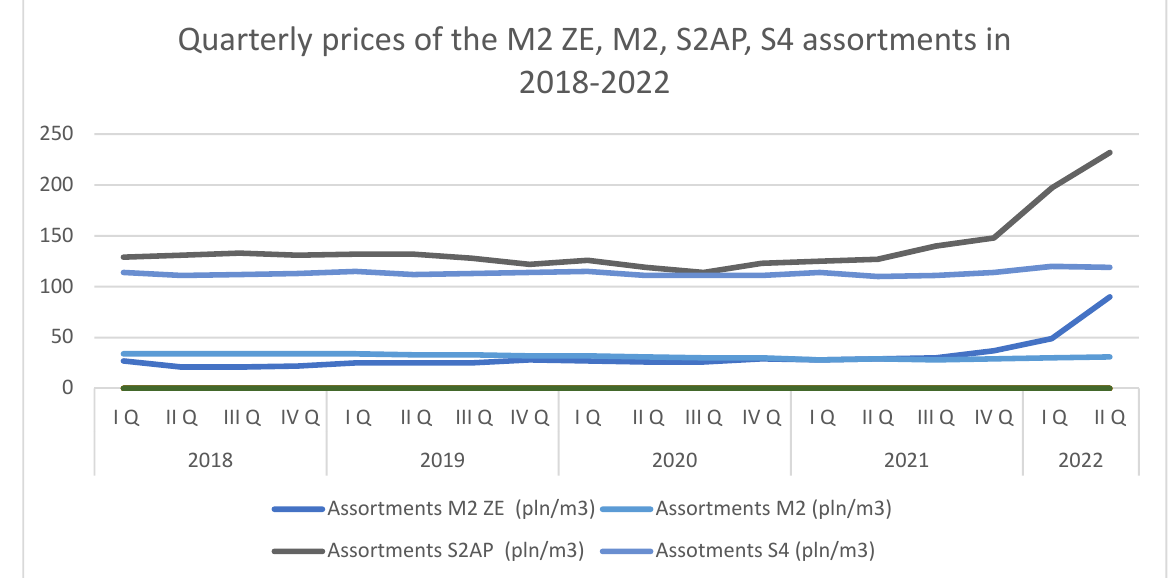
Figure 1. Quarterly prices for M2 ZE, M2, S2AP, S4 assortments in years 2018–2022. Source: Own elaboration based on data obtained from the State Forests IT System (own elaboration based on the Computer Management Support System of the State Forests National Forest Holding).